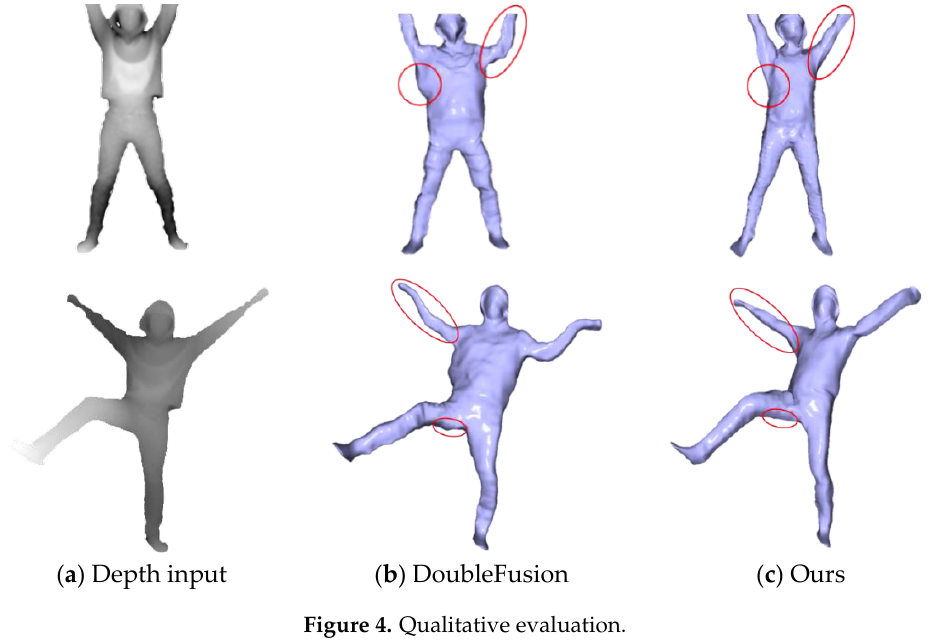
Figure 4. Qualitative evaluation.